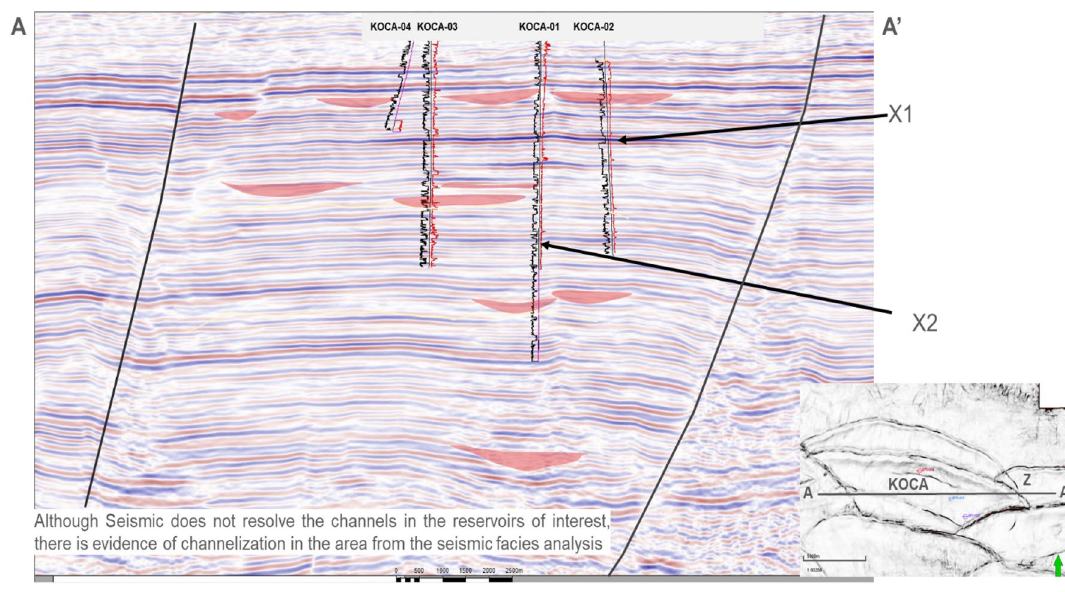
Fig. 13 Seismic facies analysis for Koca field in strike direction